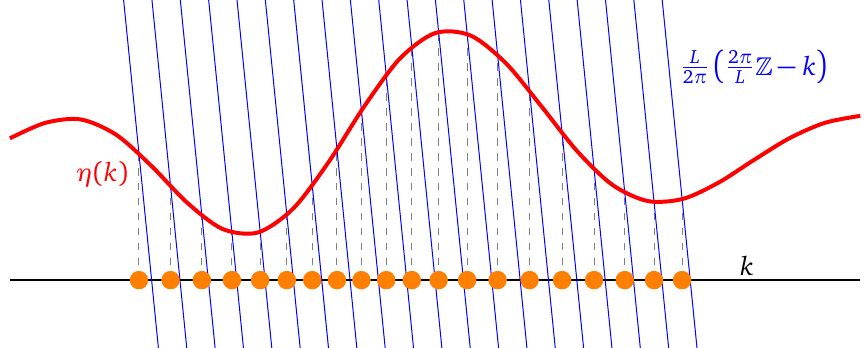
(cid:0) 2 π (cid:90) − k (cid:1) = η ( k ) for η : (cid:82) → (cid:82) . While the LHS Figure 9: Cartoon of equation L L 2 π (blue) are uniformly spaced, parallel lines, the solutions (orange dots) are not uni- formly spaced. However, as L → ∞ , the blue lines become denser and steeper, and the solutions become more uniform and less sensitive to the shape of η ( k )